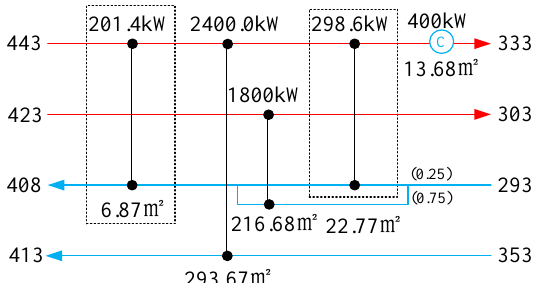
Figure 3. Solution of case 1 obtained by the stage-wise superstructure (SWS) model; the total annual cost (TAC) is 77,958 $ / a.